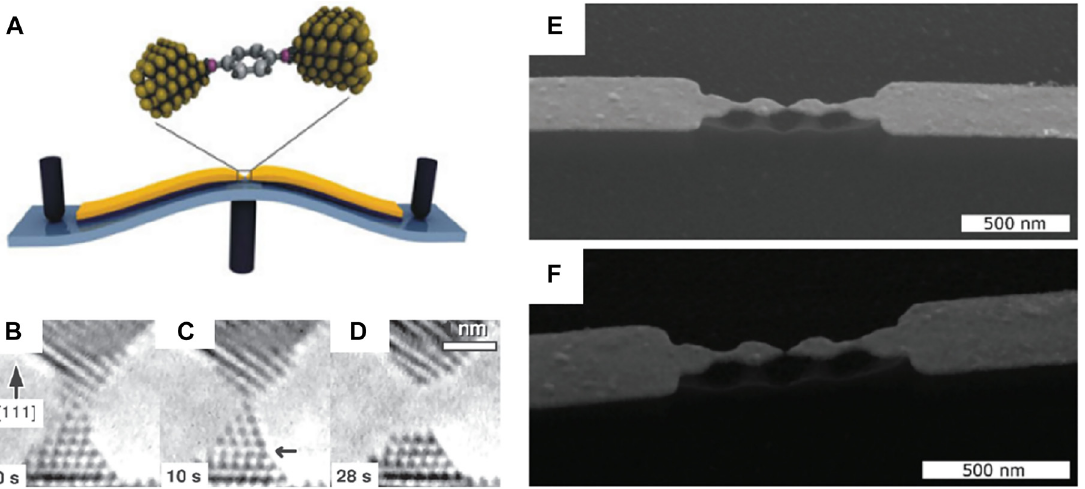
Figure 14: (A) Mechanically controllable break junction, commonly used for molecular electronic studies. (B) – (D) in-situ TEM images of an atomicallythinmetalliccontactformingabreakjunction.(E)and(F)SEMimagesofabreakjunctionbeforeandafterformationofthegap.This junction can support localized surface plasmon resonance and incorporate fi eld enhancement at the gap. Reproduced with permission from [155] (A) [156], (B) – (D) [157], (E) and